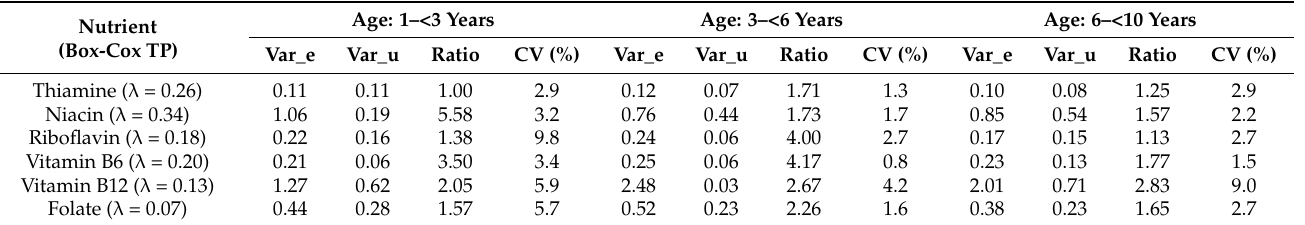
Table 10. Within-person and between-person variance, ratio of these two parameters and the coeffi- cient of variation for usual intake of thiamine, niacin, riboflavin, vitamin B6, vitamin B12 and folate, by age